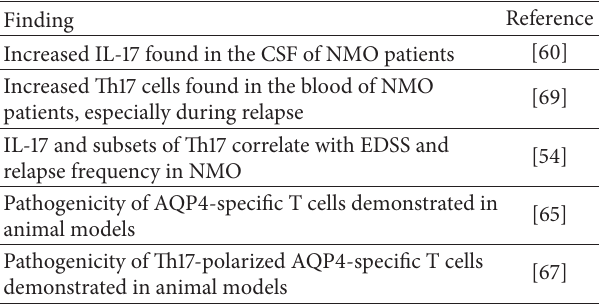
Table 2: Hallmarks on the understanding of the role of the Th17 pathways in